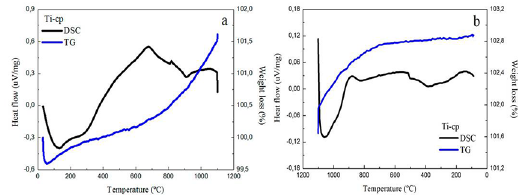
Figure 2. DSC and TG curves of cp-Ti performed at 1100°C. (a) Heating. (b) Cooling.